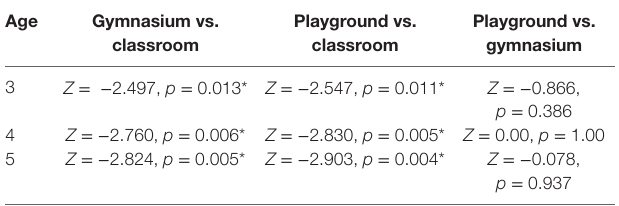
TaBle 2 | Wilcoxon pairwise comparisons. age gymnasium vs.